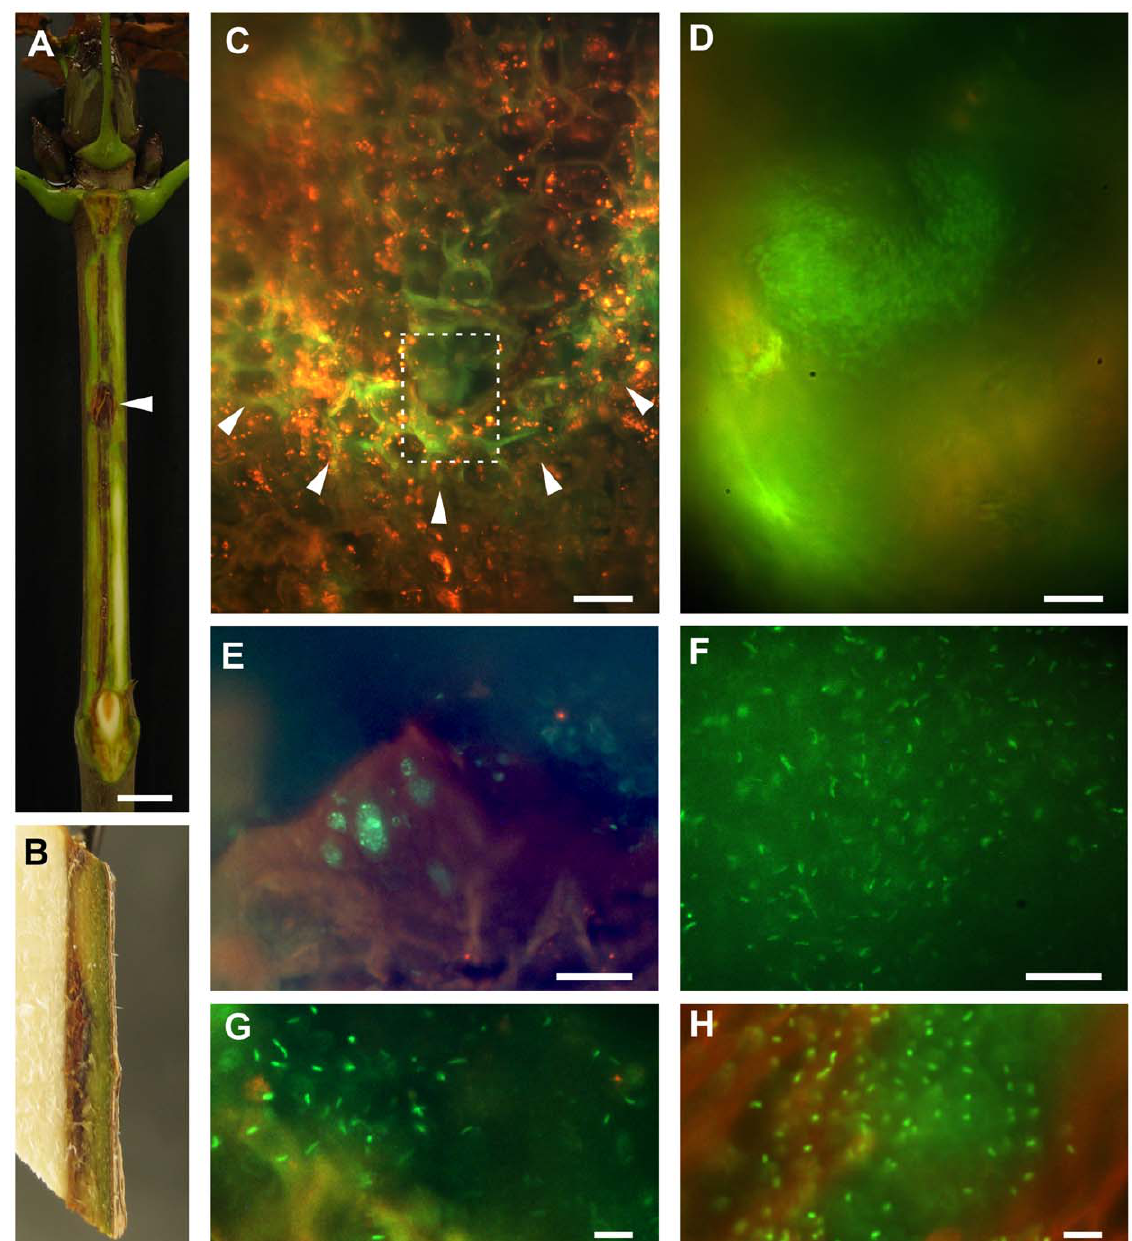
Figure 3. Behaviour of GFP-expressing P.syringaeinplanta. (A) An A. hippocastanum seedling inoculated with strain PD4818-pMP4655 photographed after 2 months shows vertical lesion expansion (up to 6 cm in length) and tissue necrosis after removal of the outer tissues of the bark. The inoculation site is indicated with an arrowhead. Note the bending of the infection around the lower node. The scale bar indicates 1 cm. (B) Side view of a longitudinally split piece of stem from a PD4818-pMP4655 inoculated seedling removed 1–2 cm from the inoculation site 4 weeks after inoculation. Necrosis and discolouration is visible in the cambial and phloem areas. (C) A longitudinal section of an infection border in bark tissue after inoculation with PD4818-pMP4655 sampled 4 weeks after inoculation. A parabolic shaped zone with elevated cell wall autofluorescence is discernible (arrowheads) with a P. s. pv. aesculi colony located in the tip of the infected zone, at about 1 cm away from the inoculation site. The boxed area is shown in detail in D. The scale bar indicates 25 m m. (D) Numerous bacteria are clustered near the forefront of an advancing lesion in parenchyma 4 weeks after inoculation. The bacteria observed here are relatively small and densely packed. The scale bar indicates 10 m m. (E) Within the necrotic area near the original site of inoculation several clusters of bacteria are found that occupy the cavities left by dead cells. Image taken from a longitudinal section of a 6 week old infection. The scale bar indicates 25 m m. (F) A large aggregate of PD4818-pMP4655 located in necrotic tissue of a 4 week old lesion. Individual bacteria were spaced apart and did not undergo any type of motility. The scale bar indicates 25 m m. (G) Detail of a PD4818-pMP4655 cluster in necrotic tissue of a 4 week old infection, emphasizing the spacing between individual bacteria. The scale bar indicates 10 m m. (H) Immunodetection of wild-type PD4818 in the necrotic tissue of a 10 week old infection showing a similar spatial arrangement of bacteria to that shown in G. The scale bar indicates 10 m m.